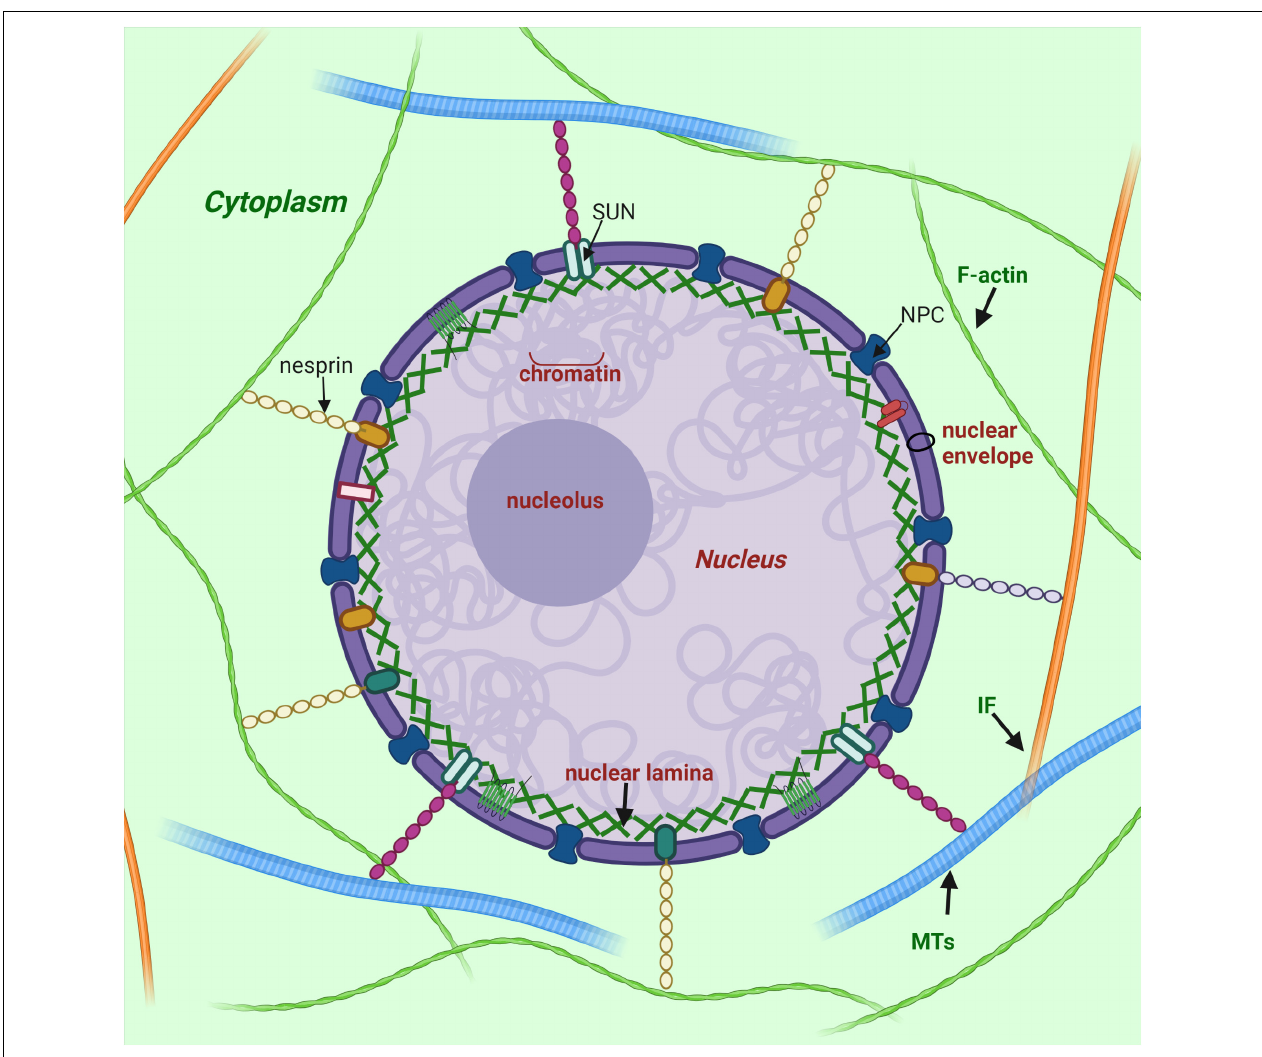
FIGURE 1 | Nuclear lamina position and its interplay with other structures of cell. Nuclear lamina is a stiff meshwork consisting of A-type lamins and B-type localized between the nuclear envelope and chromatin. Nuclear lamins interact with a wide range of nuclear envelope proteins (NEPs). Also, nuclear lamins can interact with the cytoskeleton (filamentous actin – F actin; microtubules – MTs; and intermediate filaments – IF) via SUN proteins and nesprins. Created with BioRender.com.